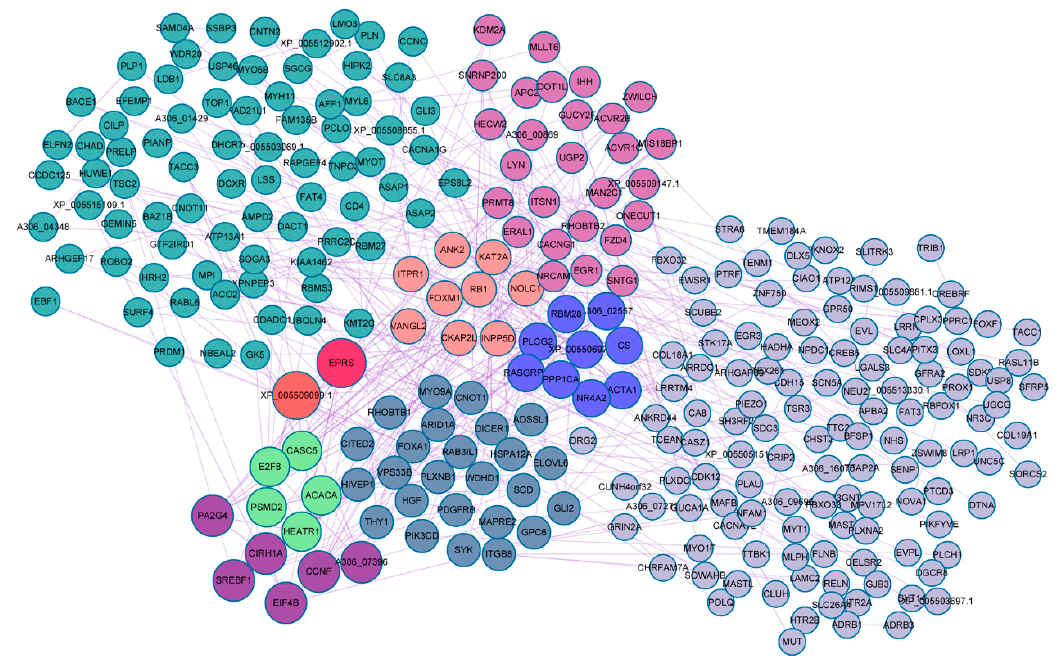
Figure 4. Summary of protein-protein interaction network of target genes of the differentially expressed miRNAs between lactating and non-lactating pigeon crops. Different colors represent modules, and size of the node represents connectedness of the node.